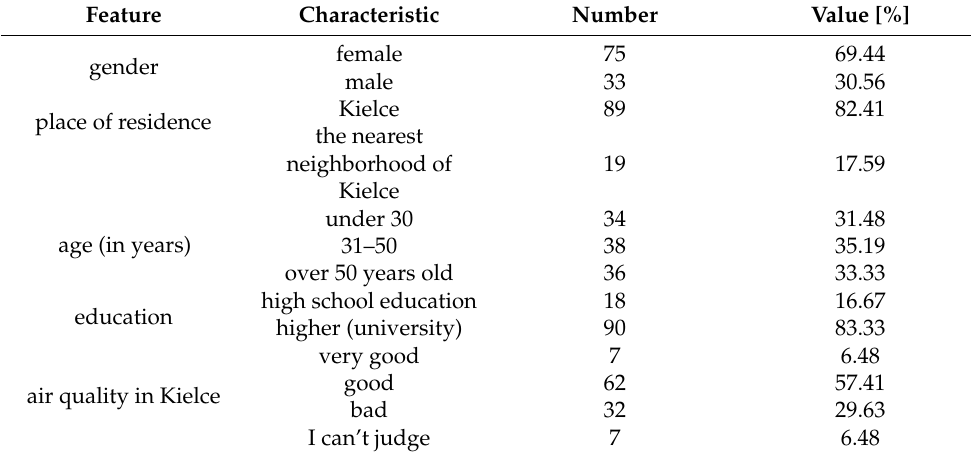
Table 2. Characteristics of respondents.